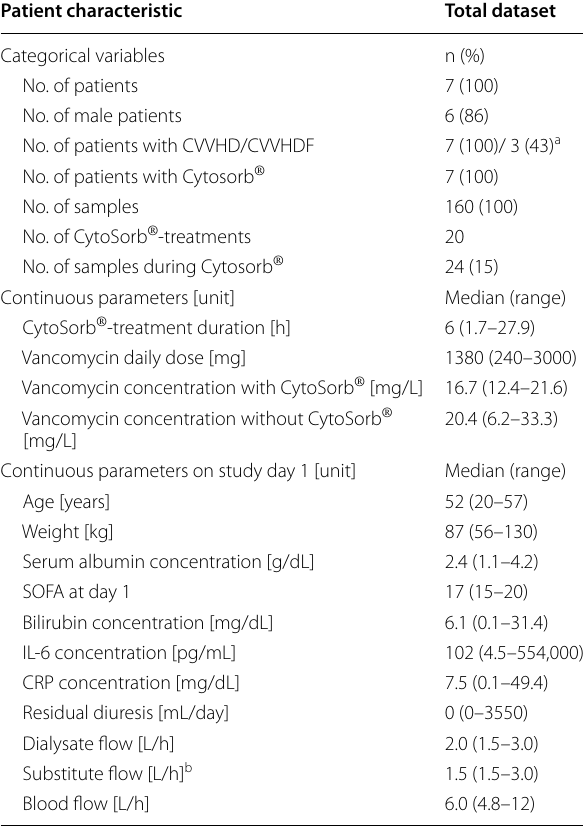
Table 1 Patient (at baseline), treatment and blood sampling